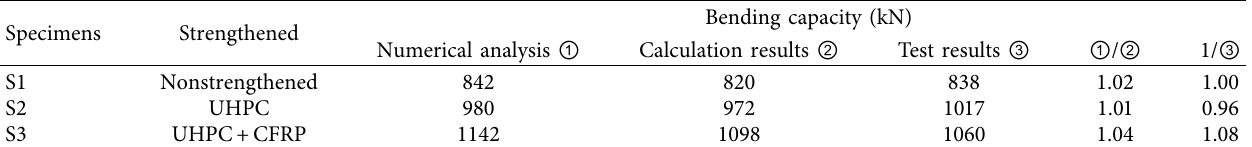
Figure 20: Calibration of hollow slabs analysis with test results. (a) Sample S1. (b) Sample S2. (c) Sample S3. Table 6: Comparison of bearing